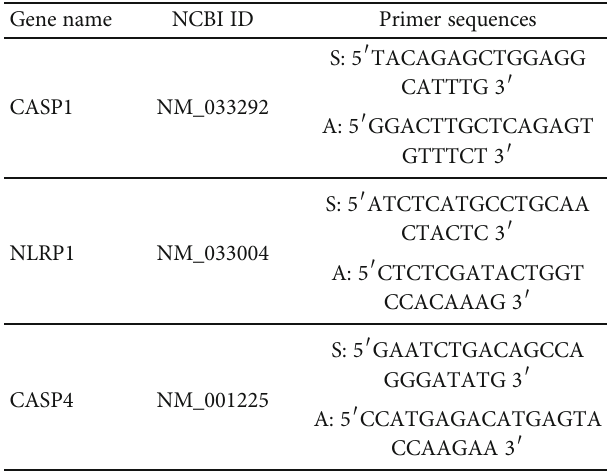
Table 2: Primer sequences for quantitative real-time polymerase chain